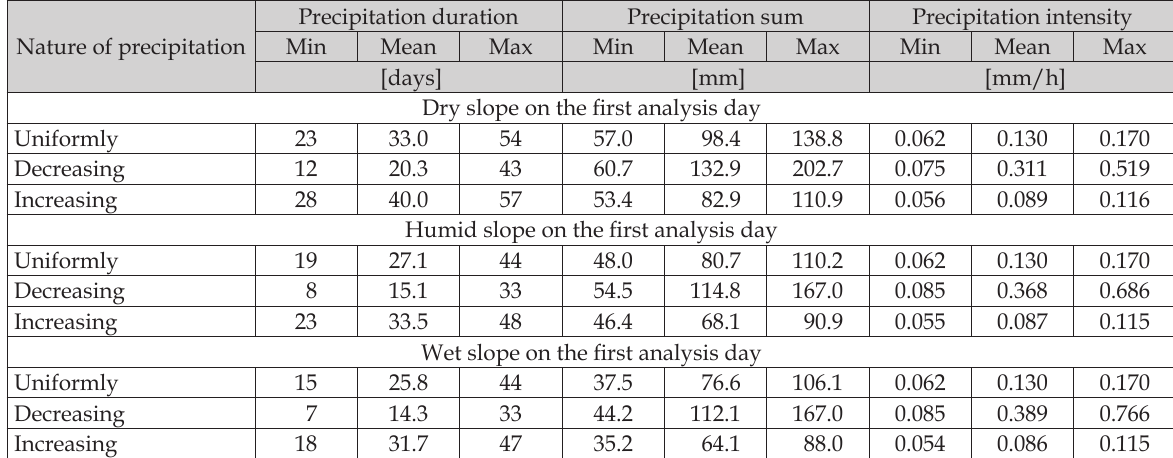
Table 3. Critical precipitation level values triggering landslides in the western part of the Nałęczów Plateau in relation to initial slope cover moisture